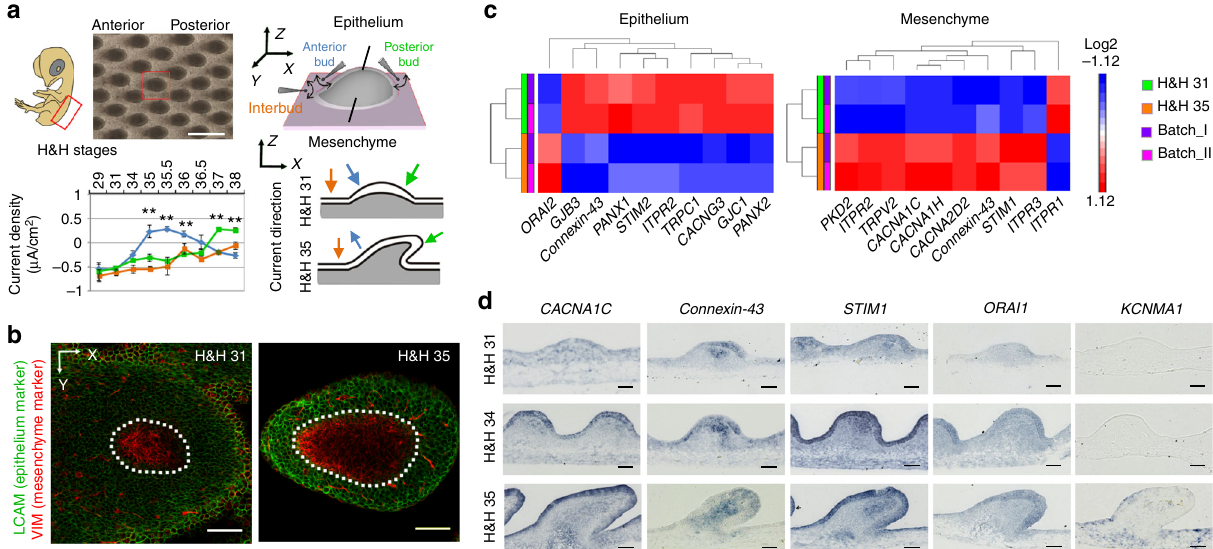
Fig. 1 Dynamic bioelectric currents and expression of Ca 2 + -related channels in elongating feathers. a Endogenous electric current density in anterior, posterior feather buds and interbud regions in intact chicken embryos at different developmental stages ( n = 9 – 11 measurements per position per stage). Between Hamburger & Hamilton (H&H) Stage 34 – 35, the direction of currents at the anterior buds reversed from inward to outward, while that at the posterior buds stayed inward. The direction of currents at interbud regions stayed inward throughout the developmental stages examined. Data are presented as mean ± s.e.m. ** P < 0.005 (two-sample Student ’ s t test). Scale bar, 500 μ m. b Confocal image of H&H 31 and H&H 35 feather buds stained with LCAM and VIM to reveal distinct morphology of epithelial and mesenchymal cells. VIM positive cells in epithelium are melanocytes and periderm cells. Dashed lines highlight epithelial-mesenchymal boundaries. Scale bars, 50 μ m. c Screening of genes encoding ion channels in RNA-Seq highlights multiple Ca 2 + -conducting channels. d In situ hybridization results of genes encoding components of VGCCs, gap junctions, CRAC